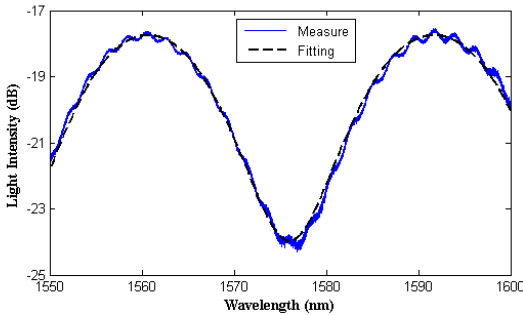
Figure 5. Measured and fitted reflection spectrum of an FFPI strain gauge.